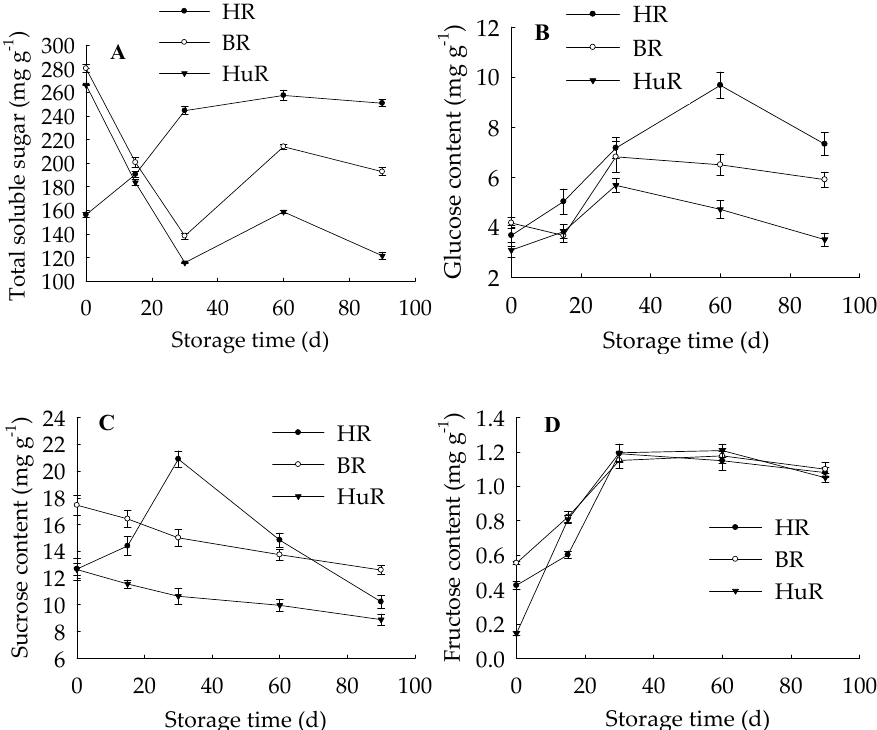
Figure 1. Changes in contents of total soluble sugar ( A ), glucose ( B ), sucrose ( C ), and fructose ( D ) in juice sacs of three pumelo cultivars. Vertical bars represent SE of the means of three replicate